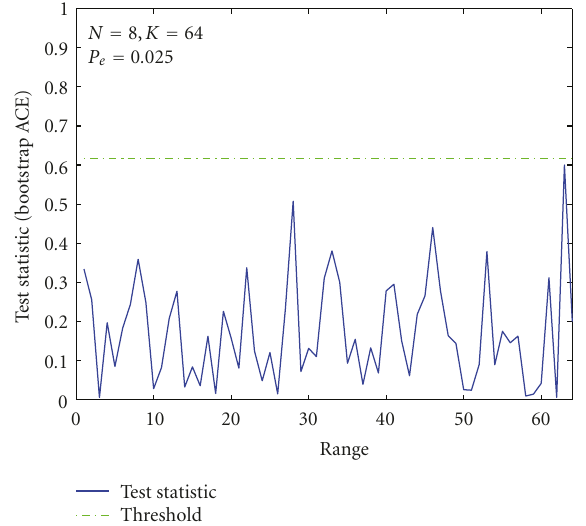
Table 9: The ratio P e /P e